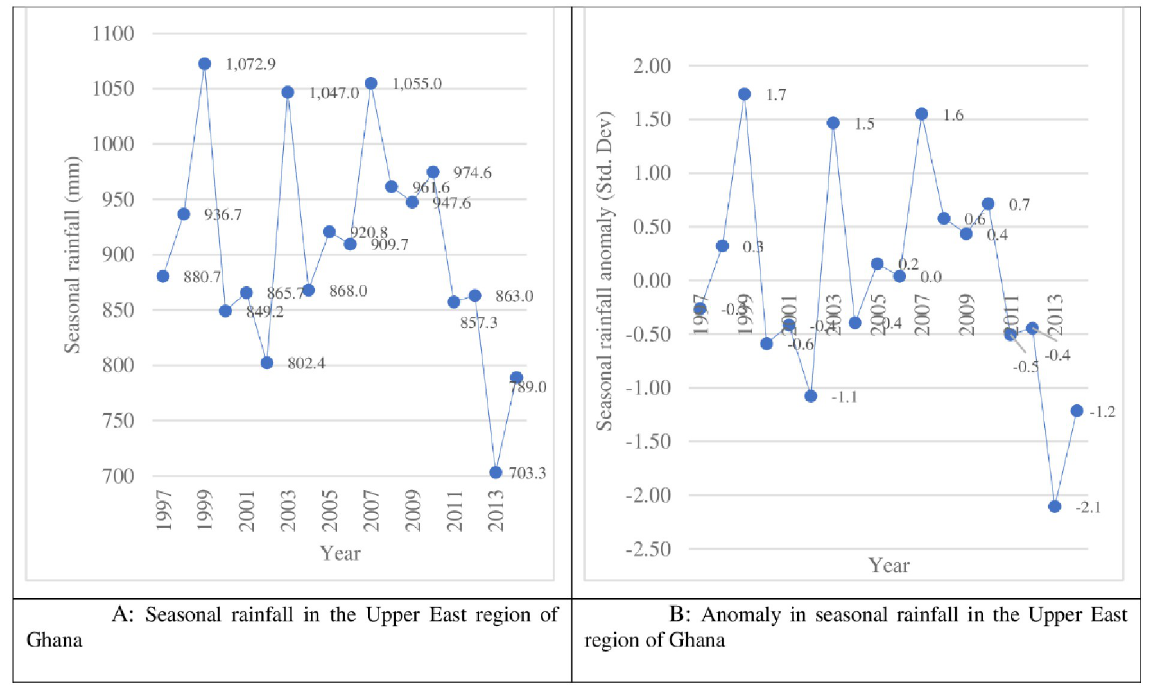
Fig 2. Rainfall in the Upper East Region of Ghana. Source: Authors (with data from NASA’s climatological database).